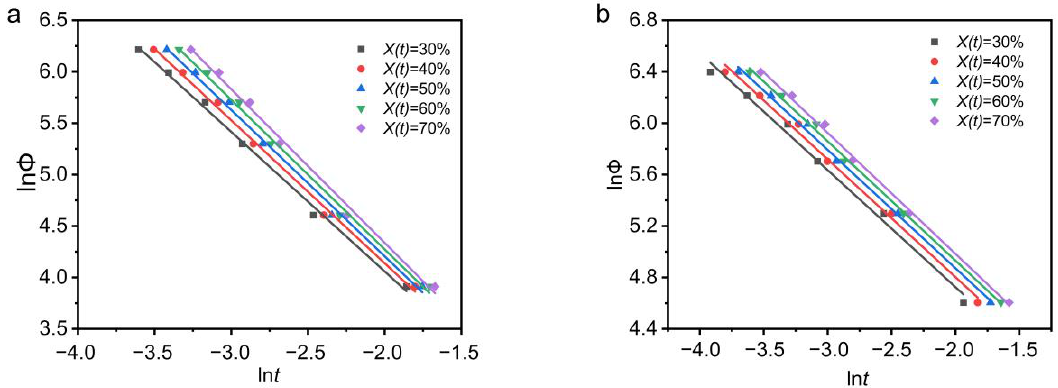
plot ln Φ versus ln t , the slope is − b, and the intercept is lnF( T ). The larger the F( T ), the lower the crystallization rate of the system. Figure 6 is a plot of ln Φ versus ln t . It can be seen that the linear relationship between ln Φ and ln t is great in Figure 6.